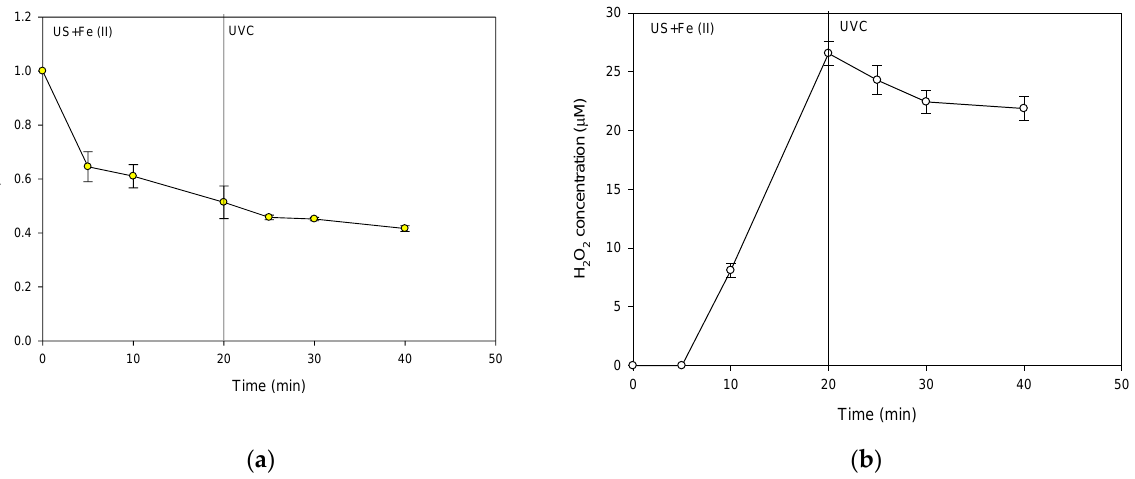
Figure 5. Sequential application of sF and UVC. ( a ) Evolution of CIP under the action of US followed by UVC irradiation; ( b ) Evolution of the H 2 O 2 accumulation during the CIP treatment under the action of US followed by UVC irradiation. Experimental conditions : f: 375 kHz, P: 34.4 W, [CIP] initial : 30.6 µmol L −1 , [Fe 2+ ]: 1.0 mg L −1 (18.0 µmol L −1 ), pH initial : 5.6, V: 250 mL, and UVC: 3.02x10 17 photons s −1 .